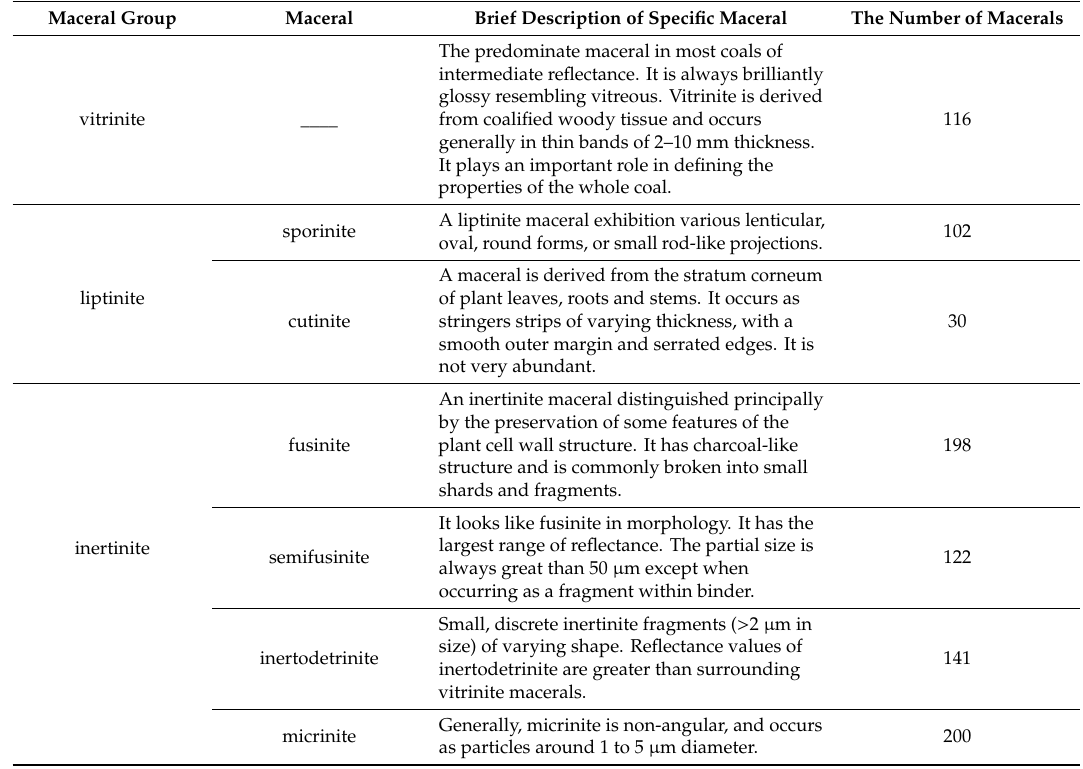
Table 1. Brief description of seven types of macerals used in this